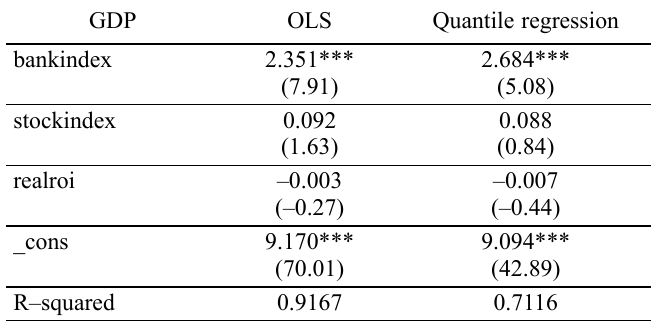
Table 5. OLS and quantile regression estimates of GDP for